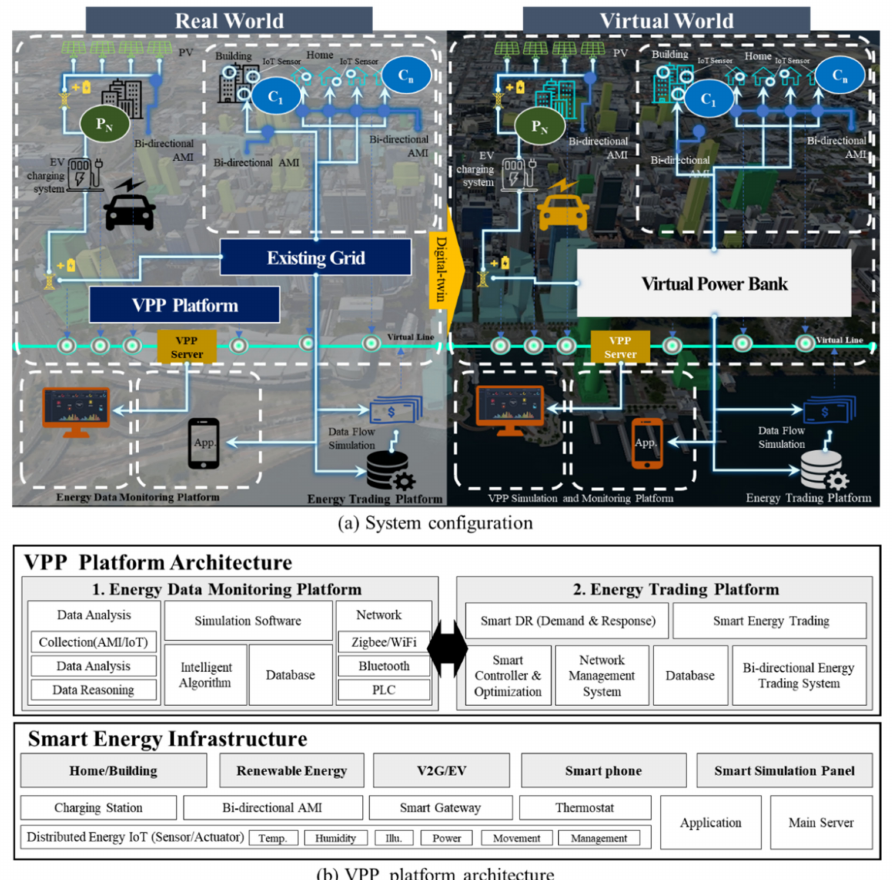
Figure 4. System configuration and